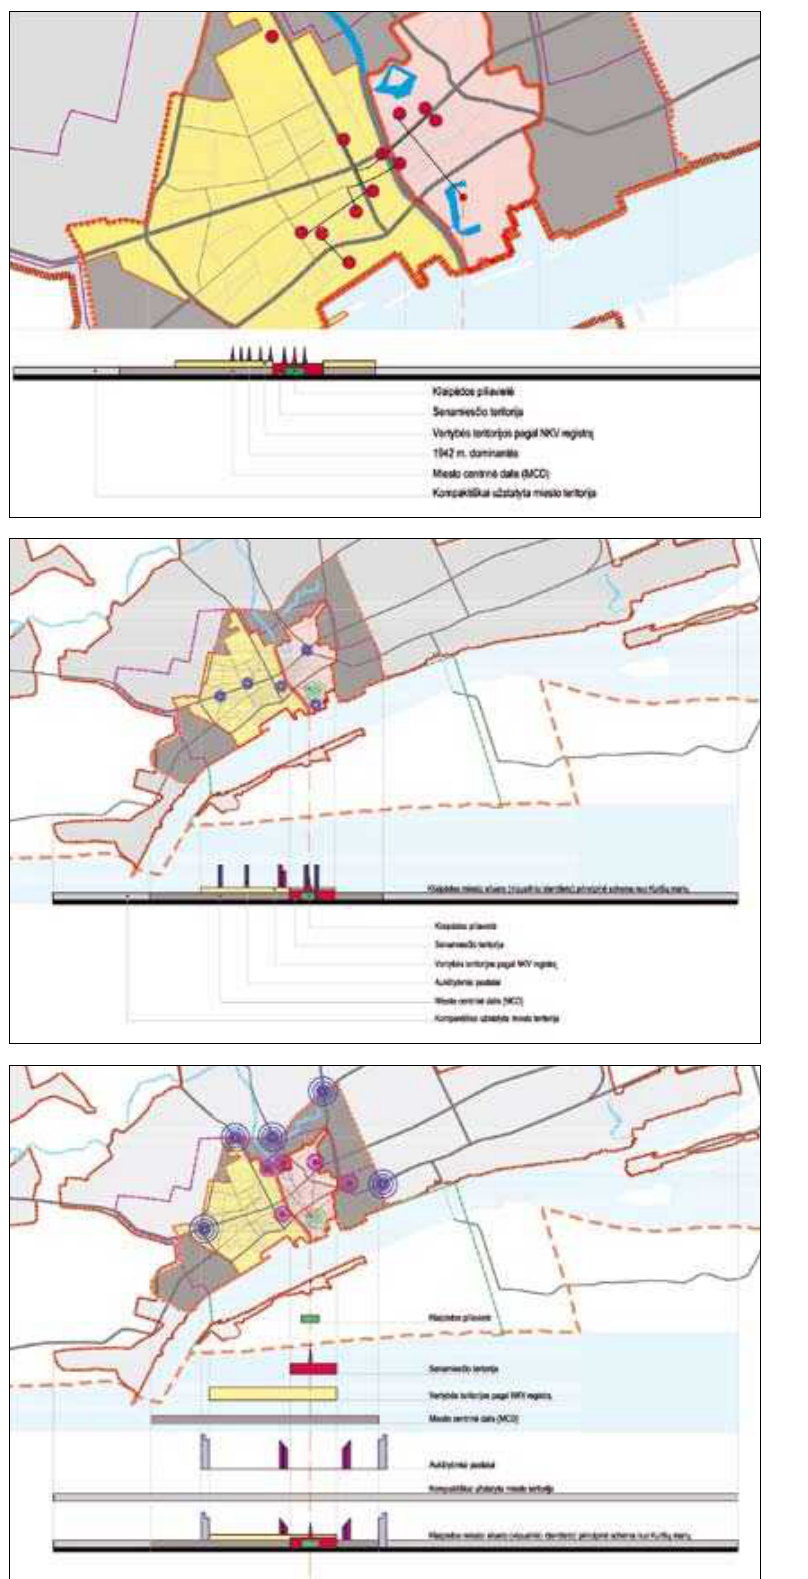
Fig. 12. Models of klaipėda city compositional framework with development of high-rise building on a central-part